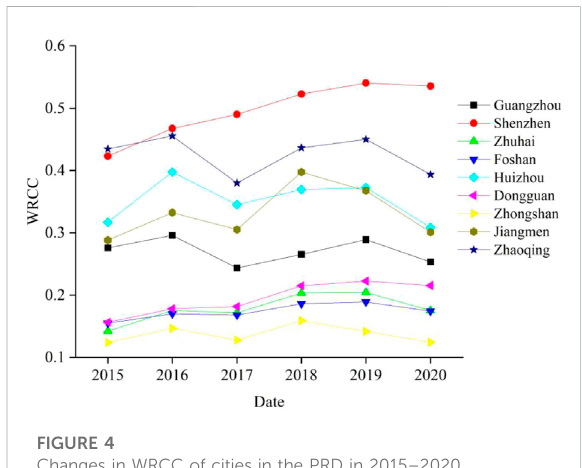
FIGURE 4 Changes in WRCC of cities in the PRD in 2015 – 2020.